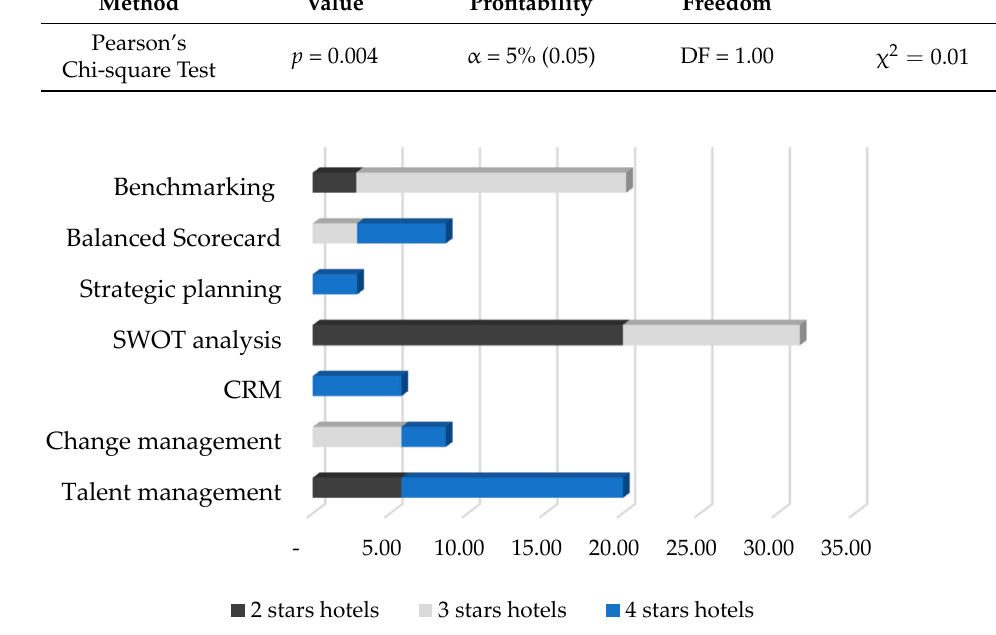
Figure 1. Relationship between the hotel’s classification category and the use of modern methods to create a plan (cumulative number). Source: Own processing.